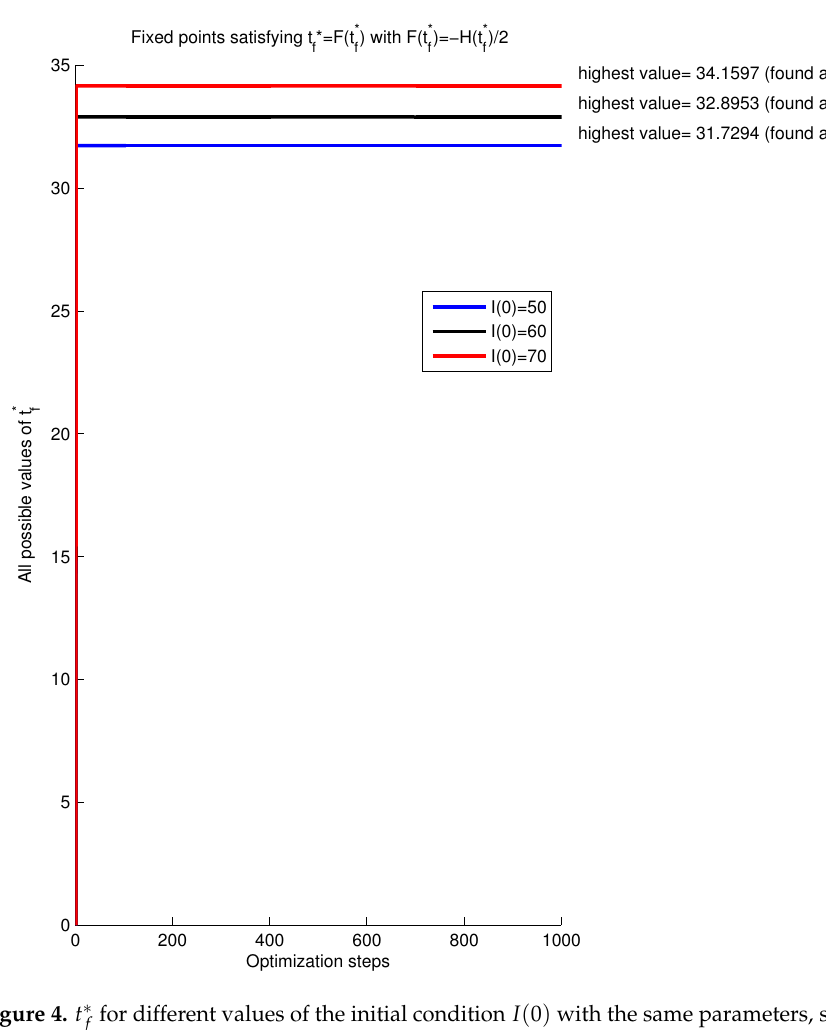
Figure 4. t ∗ for different values of the initial condition I ( 0 ) with the same parameters, severity weights f constants and , initial conditions for S ( 0 ) , C S ( 0 ) , and R ( 0 ) as in Figure